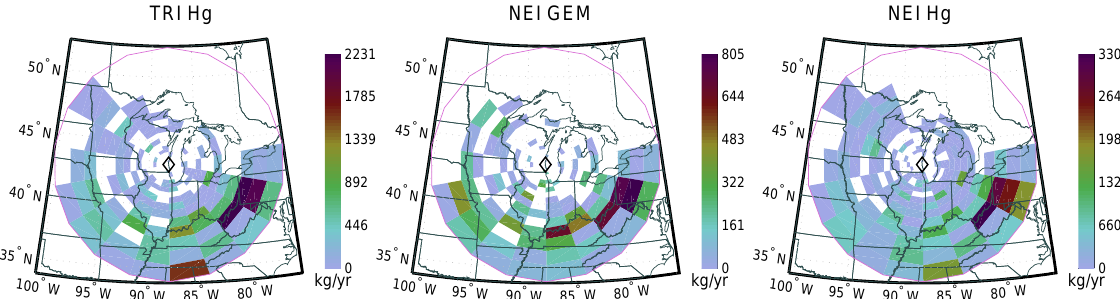
Fig. 13. Map of inventories of all mercury compounds from the Toxic Release Inventory (left), of GEM from the 2002 National Emissions Inventory (middle) and all mercury compounds from the 2002 NEI (right). Extent of the back-trajectory grid used for the inversion shown in pink. Areas with zero emissions shown in white.